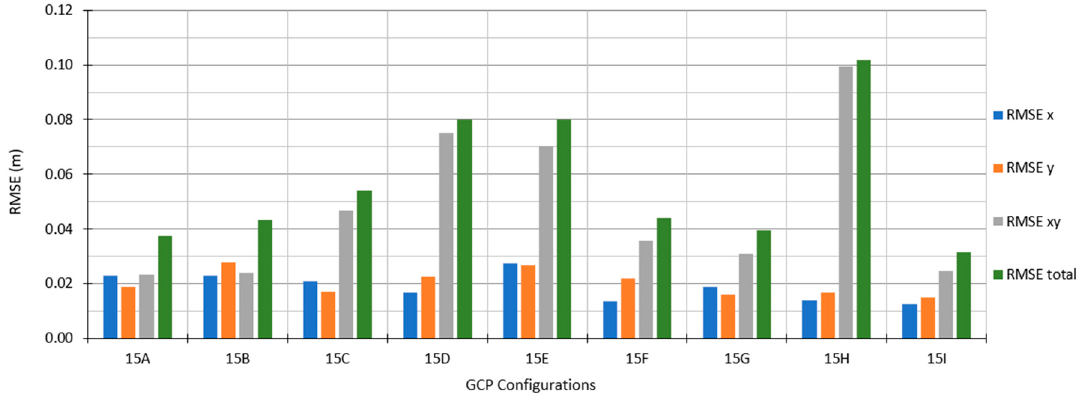
Figure 8. Check point RMSEs of the variations of GCP configurations.